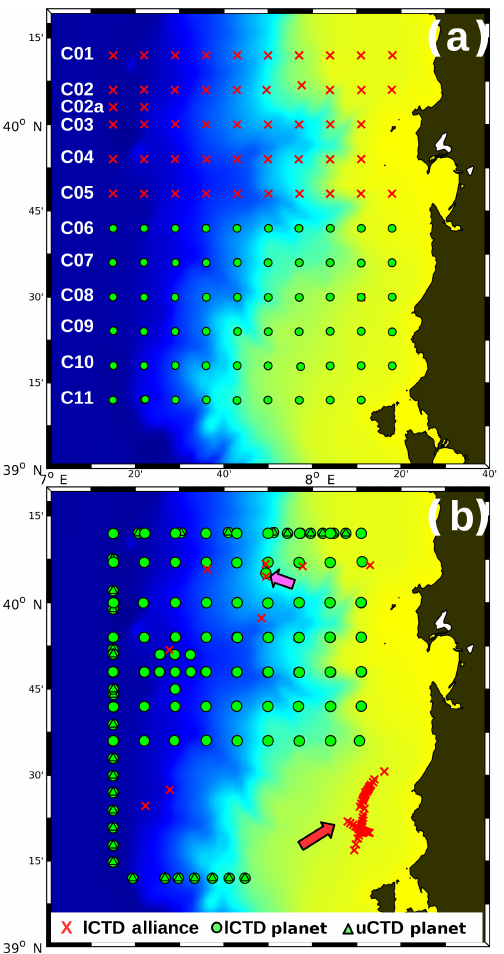
Figure 5. CTD casts taken during (a) Leg 1 and (b) Legs 2 and 3. Zonal sections in panel (a) are numbered C01–C11. The 46 CTD casts taken by Alliance in the framework of the acoustic experi- ments during Leg 2 are highlighted by the red arrow; the magenta arrow points to the position of the CTD intercalibration. Extra casts taken by Planet for the calibration of the CTD chain are not shown. The colour code for the water depth is the same as in Fig.